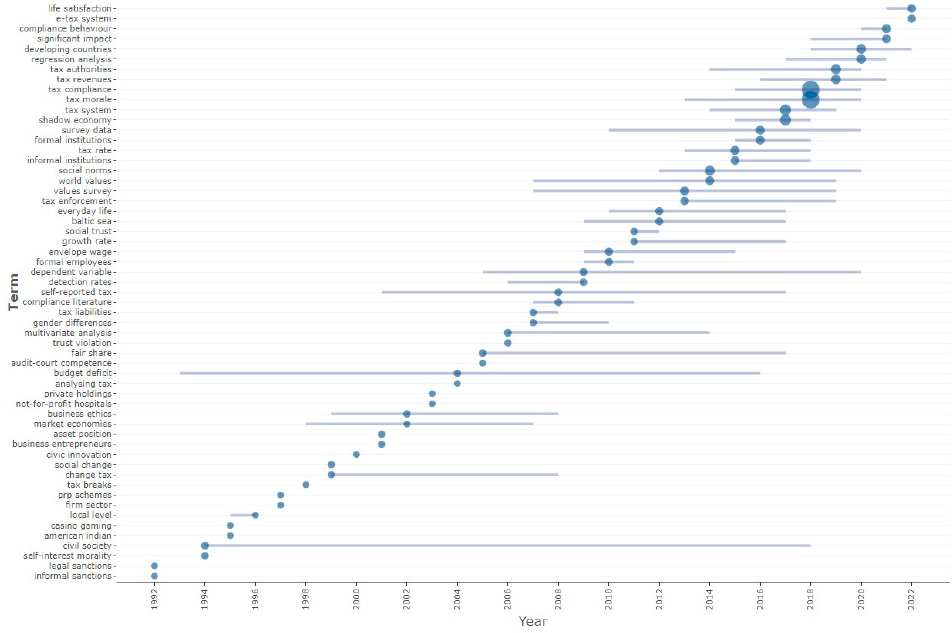
Figure 2. Trend topics over time.